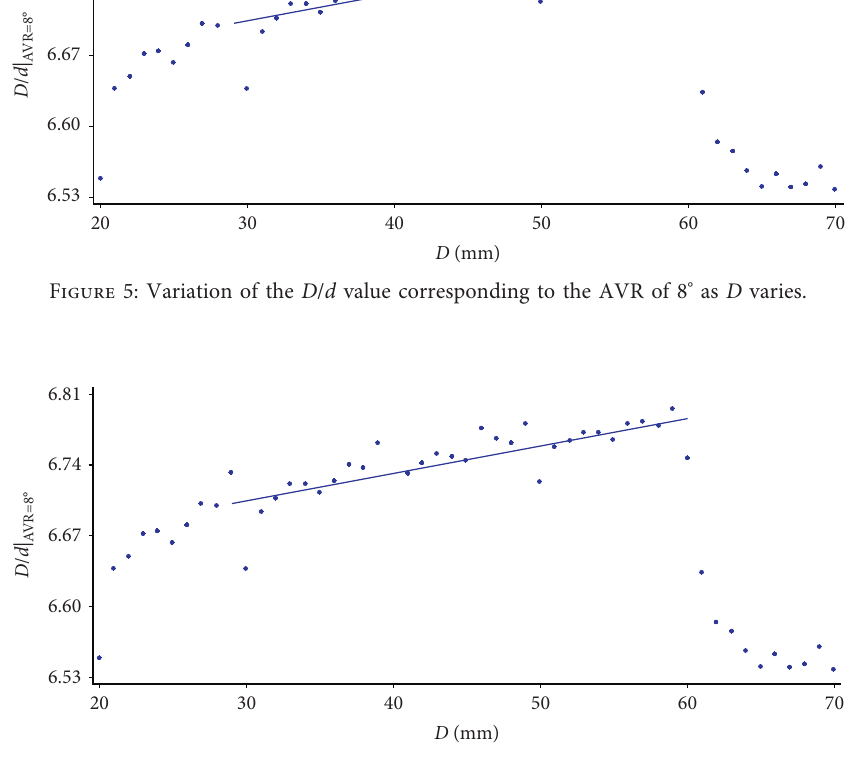
Figure 6: Variation of the D / d value corresponding to the AVR of 12 ° as D varies.